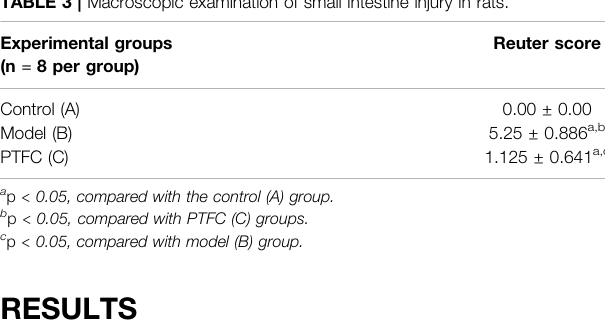
TABLE 3 | Macroscopic examination of small intestine injury in